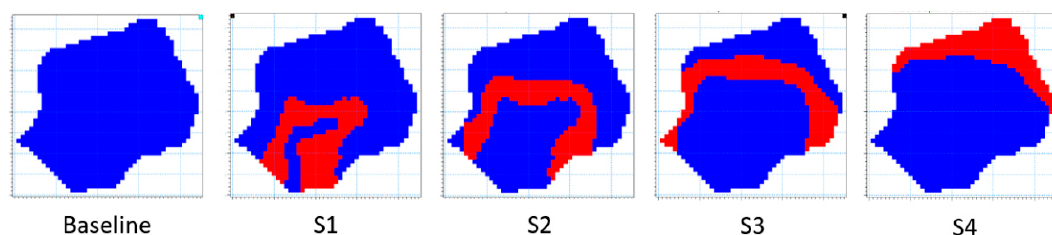
Figure 3. Configuration of the defined partial afforestation configurations: Baseline configuration with only the pasture cover for the entire catchment; S1, S2, S3 and S4 each with 25% plantation areas (in red), but varying locations and elevation.